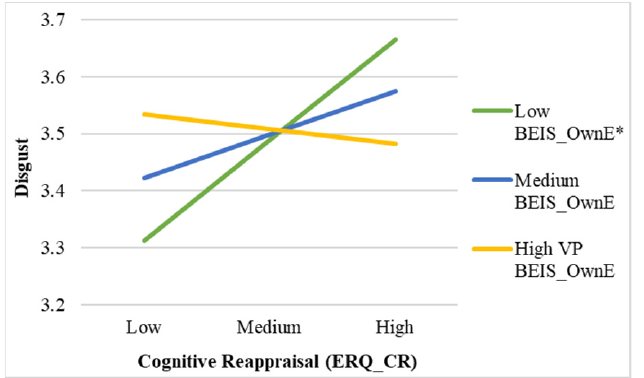
Figure A3. Plot of the relationship between Cognitive Reappraisal and Disgust at low ( − 1 SD), medium (mean), and high (+1 SD) Appraisal of Own Emotion score; * = p < 0.05.